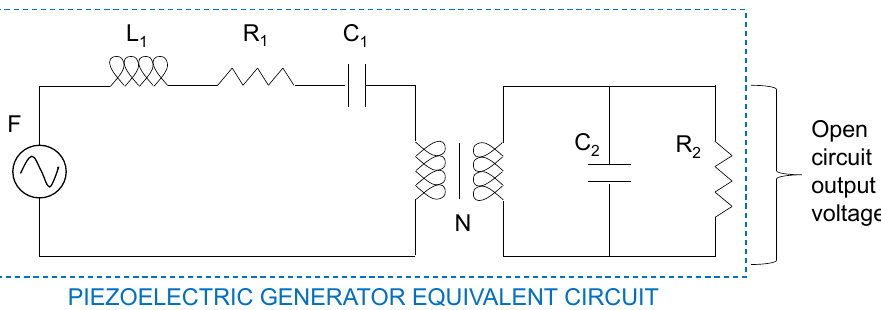
Figure 1. Piezoelectric generator equivalent circuit used to obtain the output voltage in an open circuit situation.